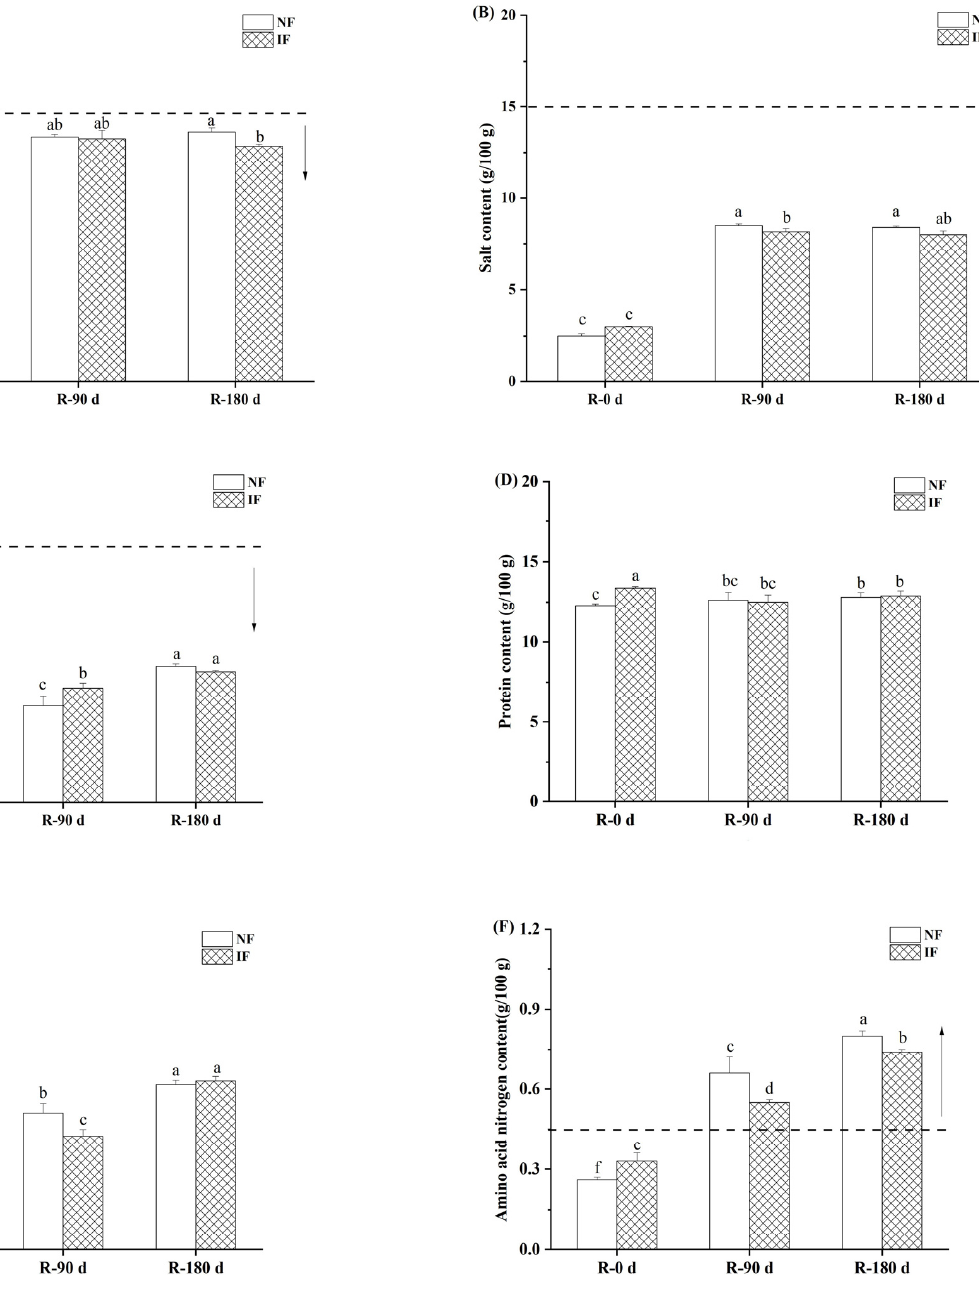
Figure 2. Contents of moisture ( A ), salt ( B ), total acid ( C ), protein ( D ), water-soluble protein ( E ) and amino acid nitrogen ( F ) in natural and inoculated fermented sufu. Note: Different lower-case letters indicated significant differences at p < 0.05. NF: natural fermentation; IF: inoculated fermentation. The dotted line is the standard requirement for each indicator of mature vegetarian curd; the arrow facing up indicates that mature vegetarian curd needs to be greater than the value; the arrow facing down indicates that mature vegetarian curd should be less than the